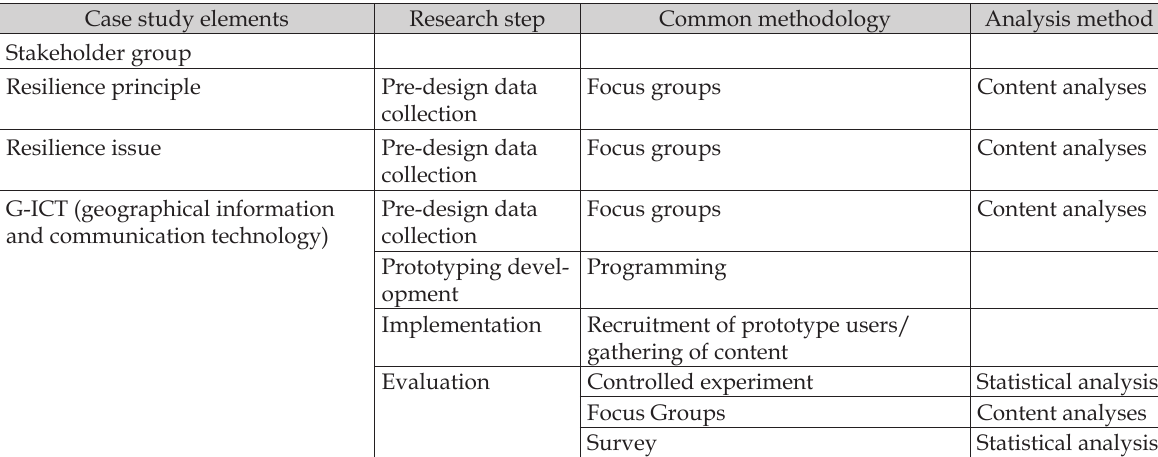
Table 1. The complementary case study approach involves three case studies in Dublin, Nottingham, and Lon- don (by A. Corcoran and Z.